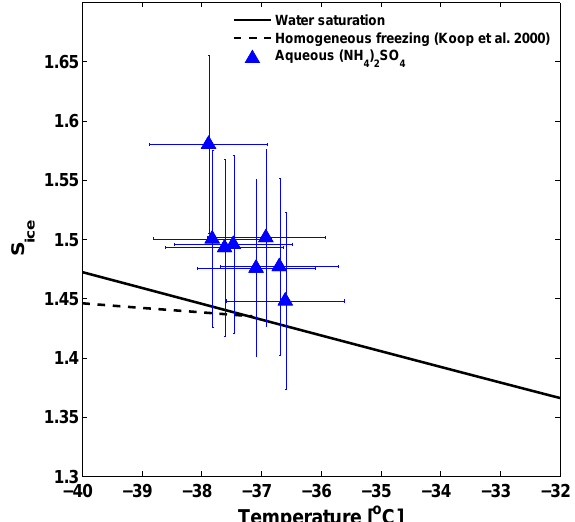
Figure 2. Homogeneous freezing temperatures of highly diluted ammonium sulphate droplets measured with SPIN. The frozen frac- tion here is 10%. The uncertainties in temperature and ice satura- tion ratio shown here correspond to the 95% confidence interval calculated from the statistical standard deviation. The homogeneous freezing line from Koop et al. (2000) is calculated for 500nm parti-